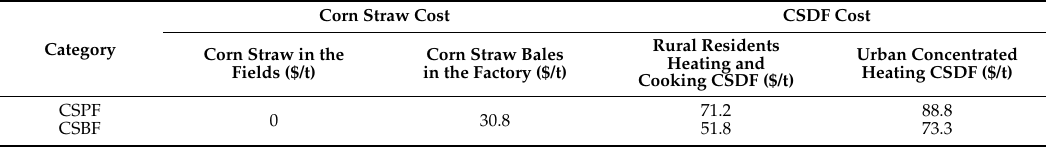
Table 8. Cost of corn straw and CSDF in the BMS.